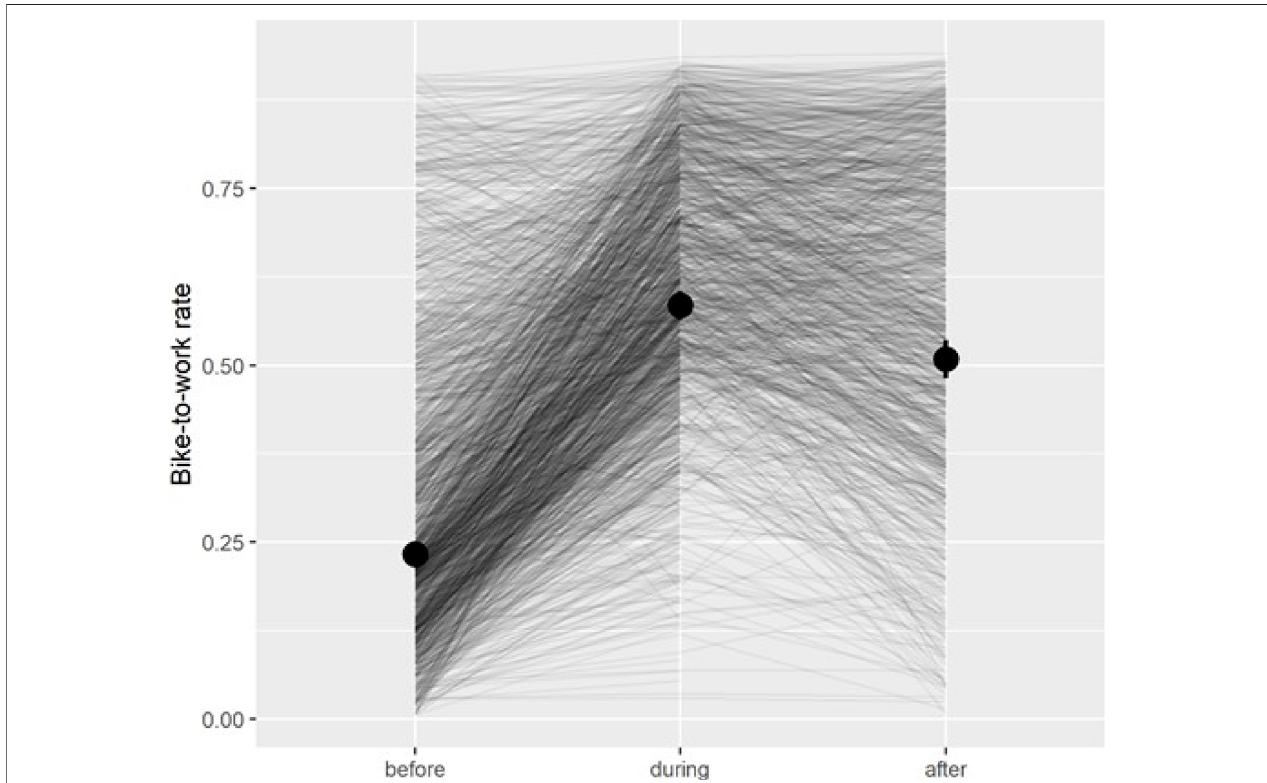
FIGURE 11 | Model predicted bike-to-work rate of bike-lending participants by intervention phase from trip logs (before, during, after).